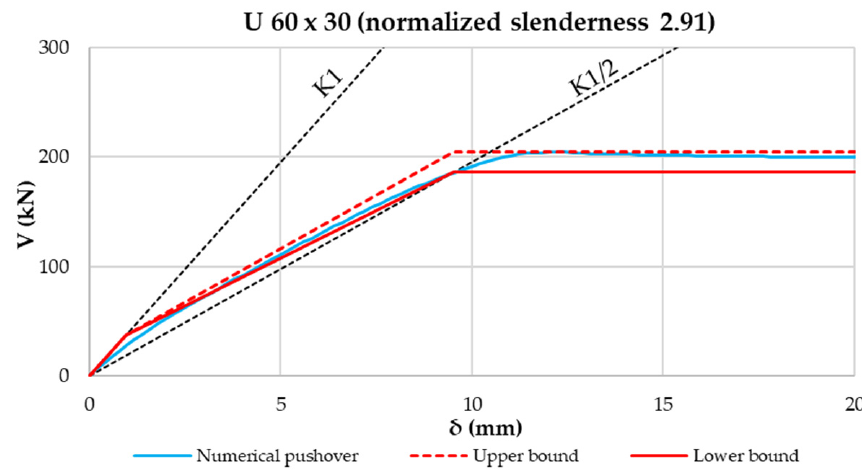
Figure 13. Comparison between analytical pushover curves and numerical one for the profile U 60 × 30. Some like “x” means “×”.